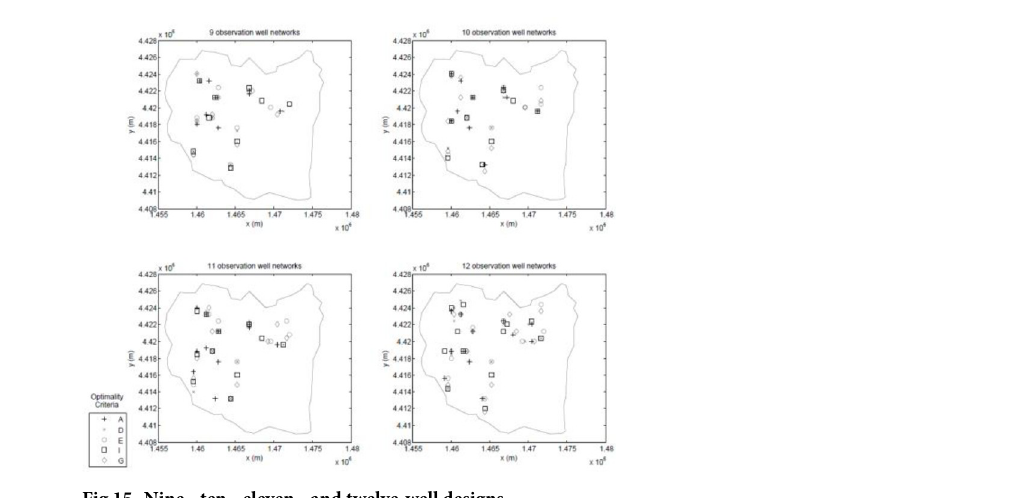
Fig 15. Nine-, ten-, eleven-, and twelve-well designs.